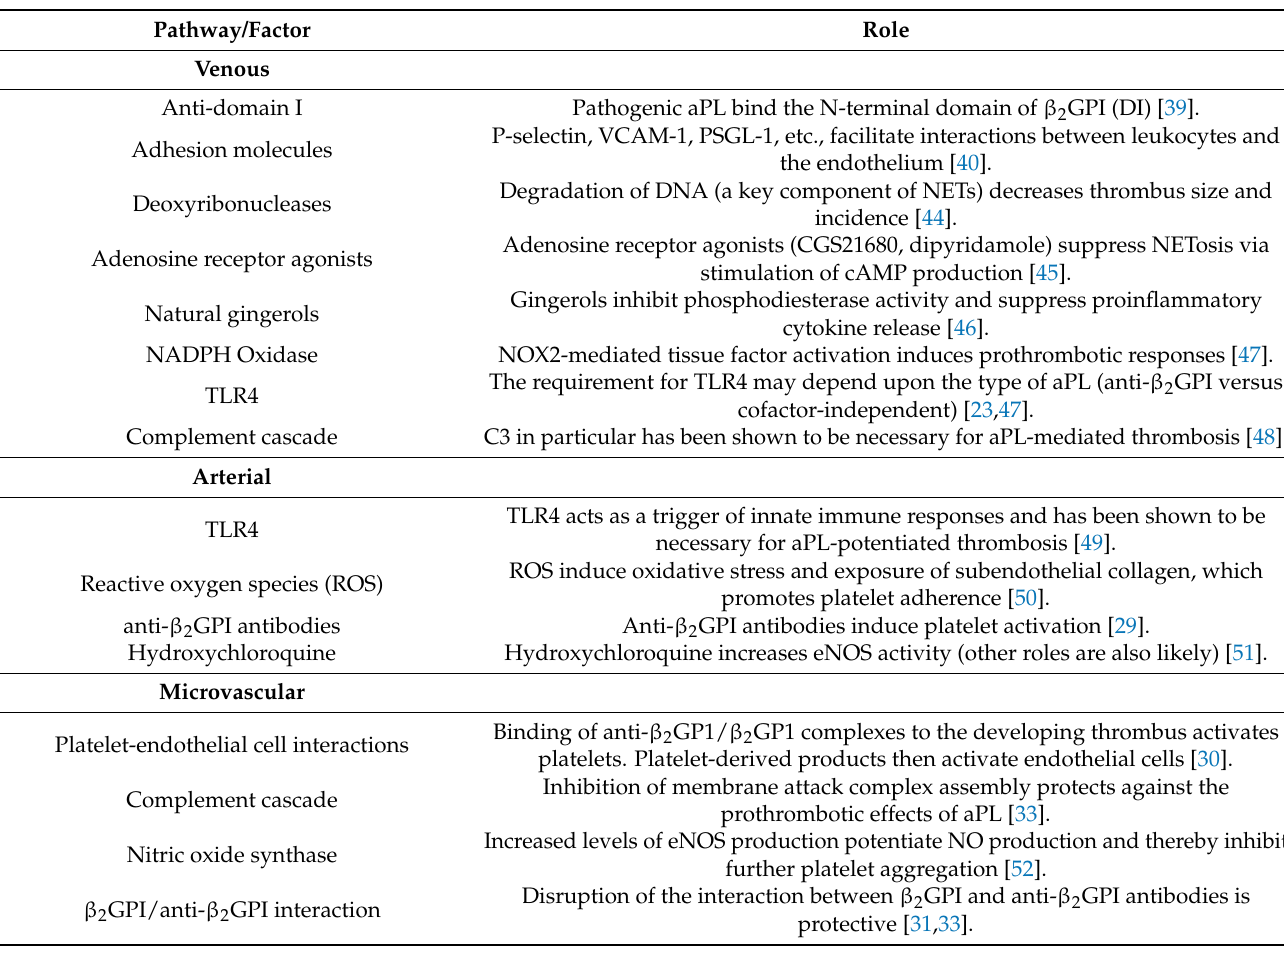
Table 2. Mechanisms of APS-associated thrombosis investigated using animal